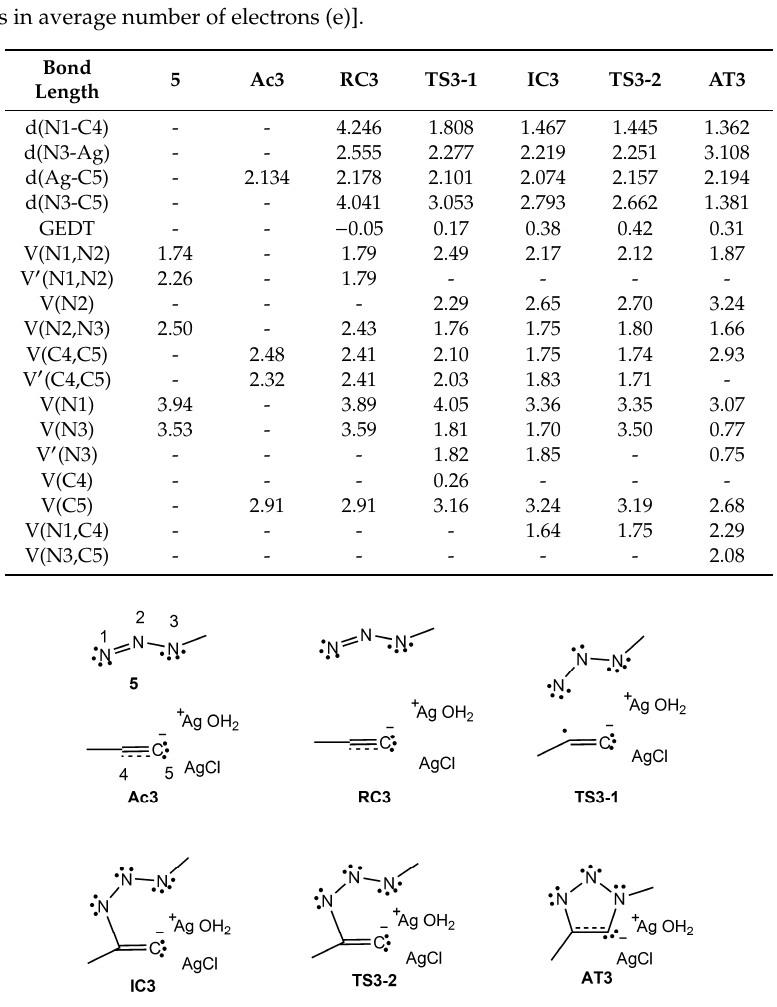
Figure 14. ELF-based Lewis-like structures of the stationary points involved in the dinuclear zw -type AgAAC reaction of Ac3 with 5.